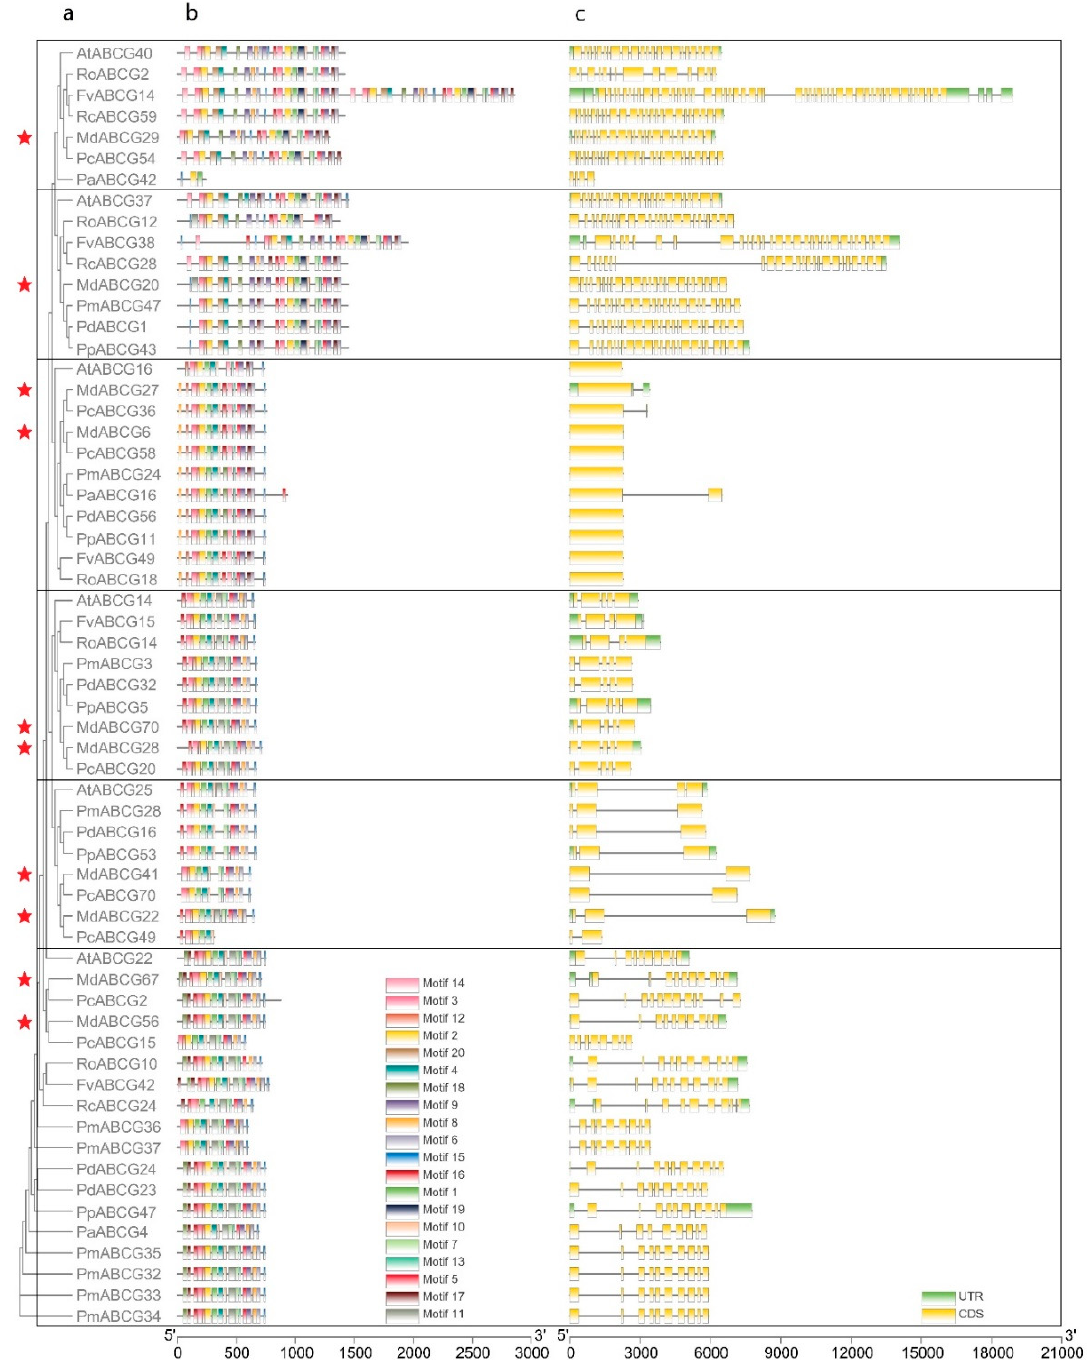
Figure 2. Phylogenetic trees, motif analysis, and gene structures of potential phytohormone transporters in ABCG subfamily genes of nine Rosaceae species. ( a ) The phylogenetic tree was constructed on the basis of the full-length sequences of known phytohormone transporter genes in Arabidopsis and homologous genes in nine Rosaceae species using the neighbor-joining (NJ) method and 1000 replications for bootstrap analysis in MEGA 6.0. Red stars indicate apple homologues. ( b ) Motif analyses. Twenty motifs are indicated with di ff erent colored boxes. Logos of each motif are shown in Table 1. All motifs were identified via online analysis with the package MEME Suite 5.0.2. ( c ) Gene structures. Exons are represented by yellow boxes. Black lines connecting two exons represent introns. Green boxes represent untranslated regions (UTRs). Gene structure maps were drawn with TBtools.